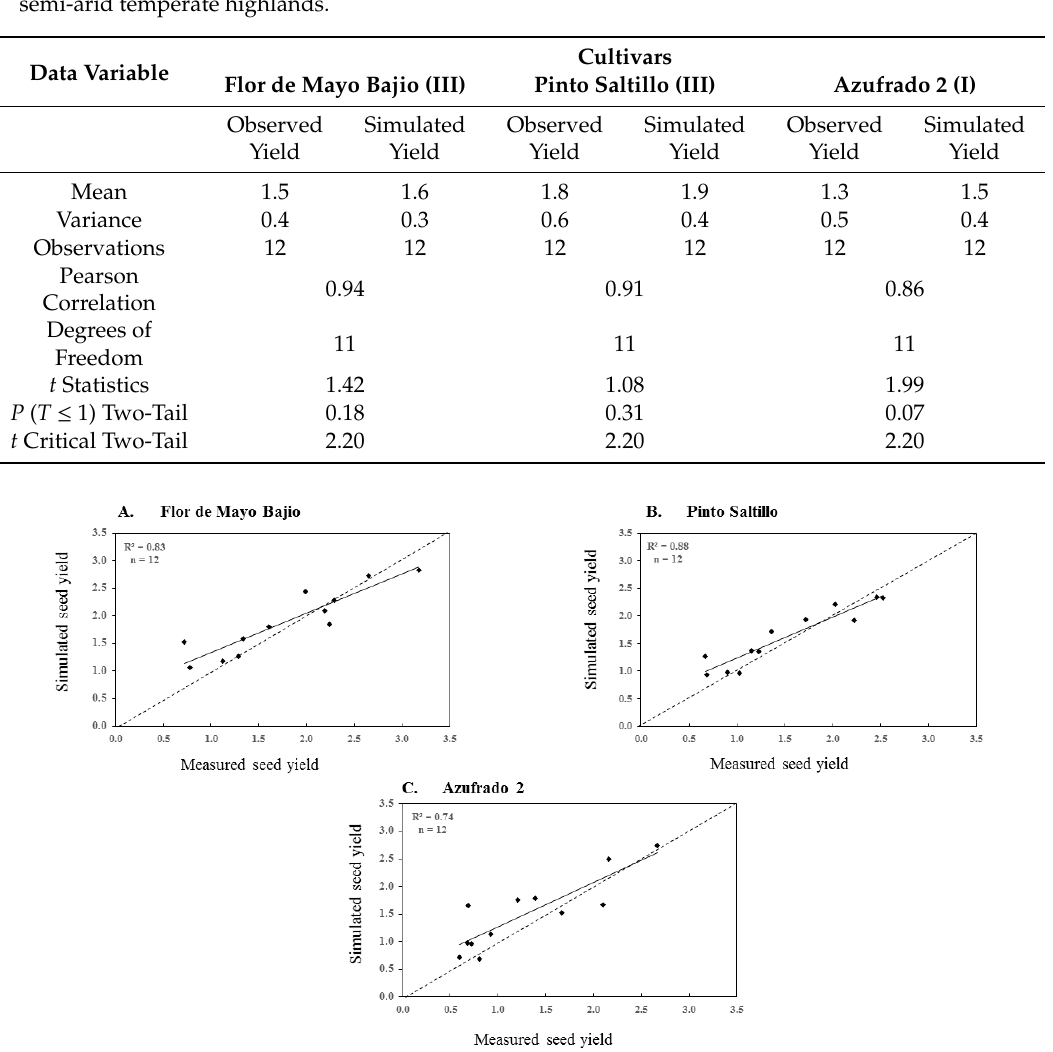
Figure 2. Simulated and observed seed yield (Mg ha − 1 ) of three common bean cultivars growth habit III (Flor de Mayo Bajio and Pinto Saltillo) and growth habit I (Azufrado 2) under rainfed conditions in Mexican semi-arid temperate highlands.